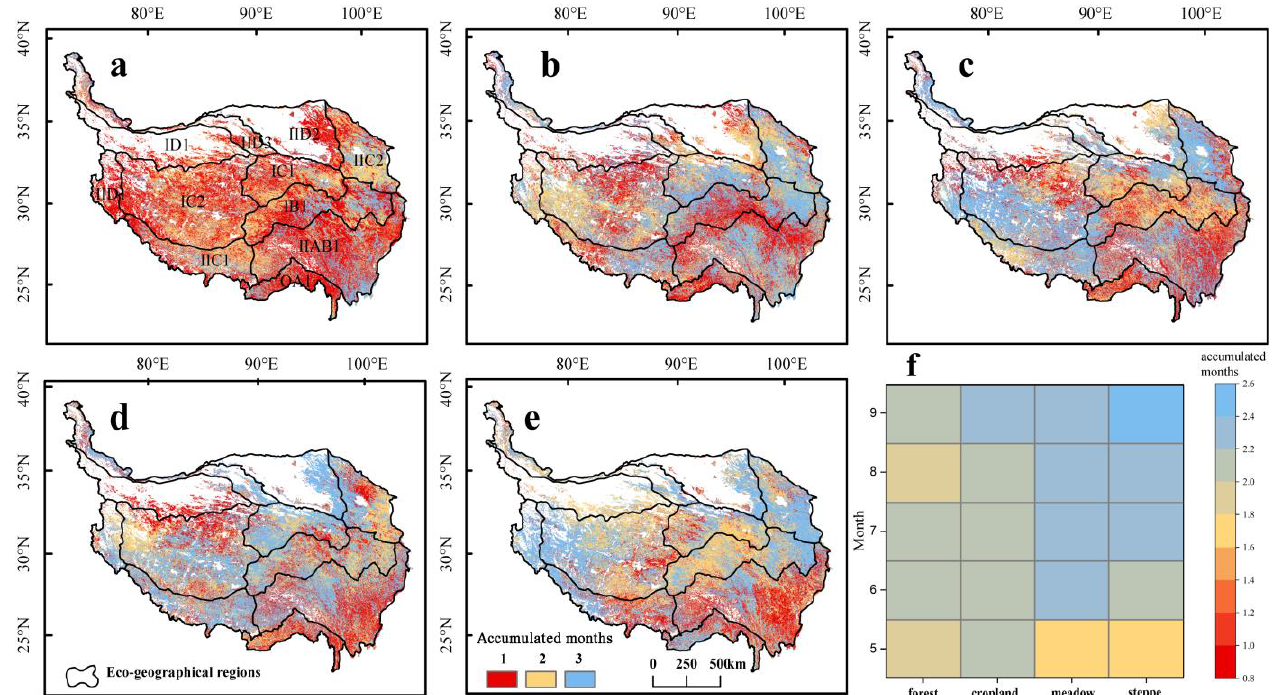
Figure 6. Spatial distribution of the corresponding accumulated months when the largest correlation coefficient r max − cum occurred. ( a ) May; ( b ) June; ( c ) July; ( d ) August; ( e ) September. The corresponding accumulated months (i) of different vegetation types when r max−cum occurred ( f ).